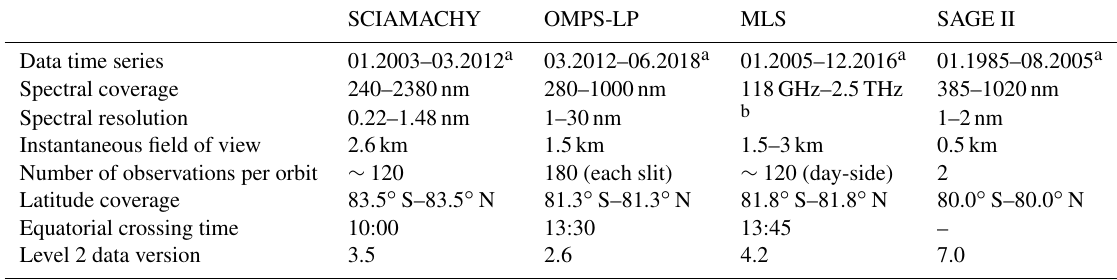
Table 1. Main characteristics of SCIAMACHY, OMPS-LP, MLS and SAGE II instruments.